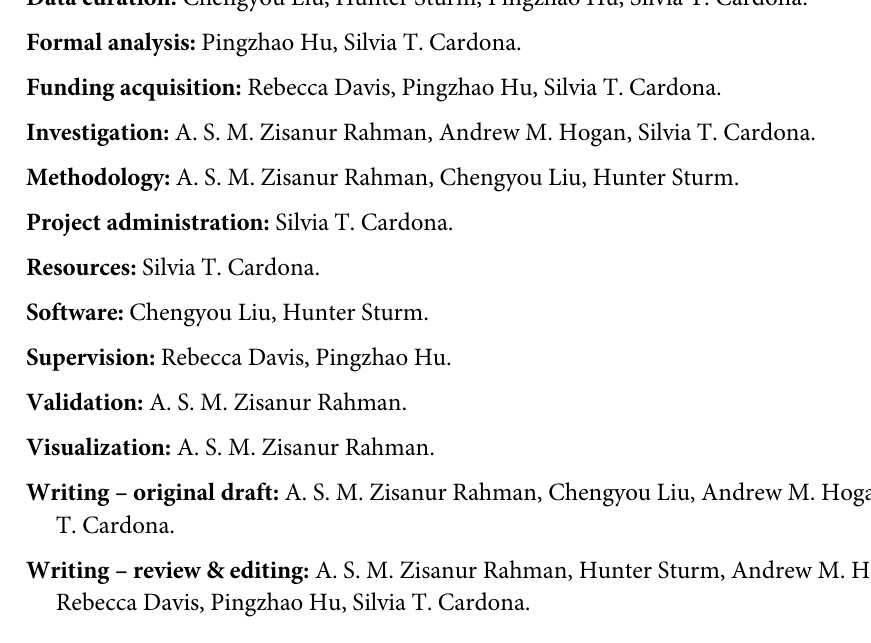
S7 Table. Natural Product library. S8 Table. Top ranked compounds from the natural product library. S9 Table. Synergy score for STL558147 in combination with other clinically used antibiot- ics. S10 Table. Analogs of PHAR261659 (related to Figs 3B and 5). (PDF) S11 Table. Bacterial strains and plasmids used in this work.